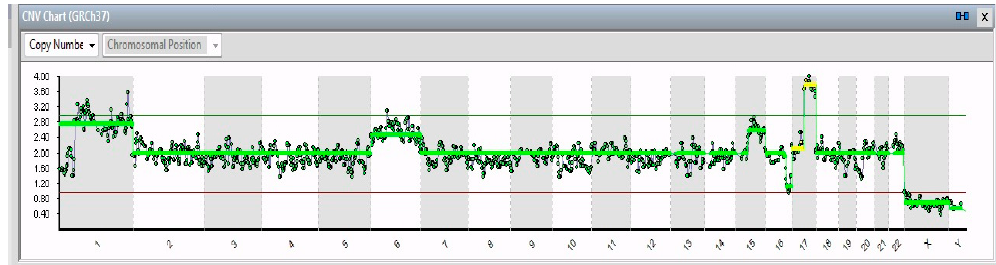
Figure 1. CNV chart related to a single cell from IMR-32 showing, from left to right, partial gain of chromosome 1, total gain of chromosomes 6 and 15, a partial loss of chromosome 16, a partial gain in chromosome 17, and the total loss of the X chromosome.